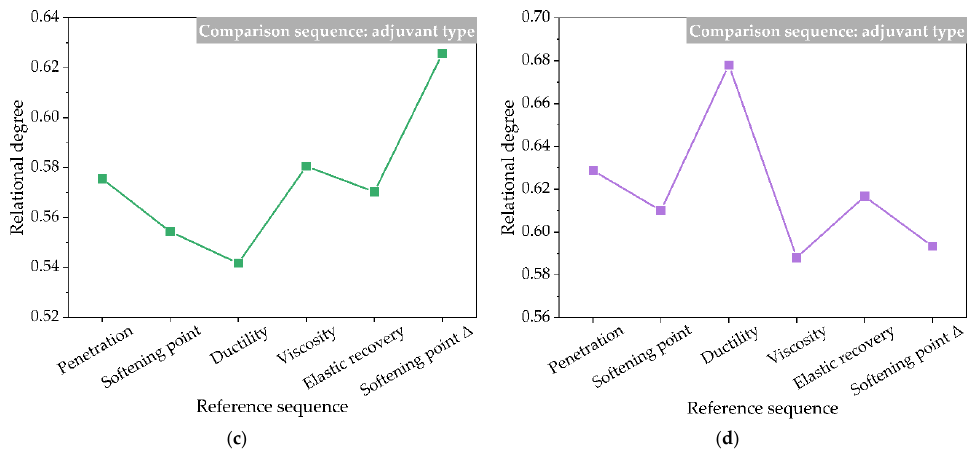
Figure 14. The grey relational degree results taking conventional physical properties as reference sequences considering different comparison sequences: ( a ) heat duration; ( b ) heat temperature; ( c ) adjuvant types for the chemical treatment; and ( d ) adjuvant types for the mechanochemical treat-